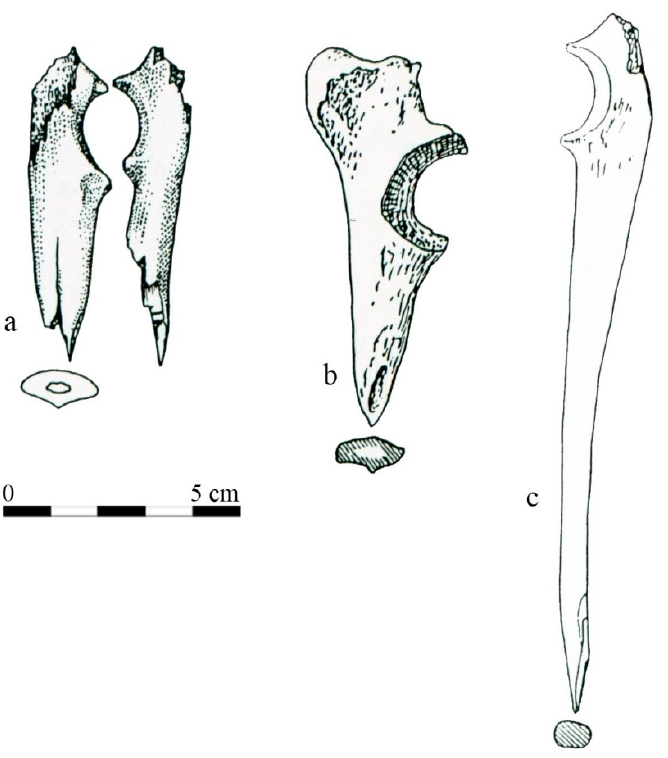
Figure 6. Points made of dog ulna from the Cathedral Island in Wroclaw, ( a – c ) According to [54]. Reproduced with permission from K. Jaworski, Wytwórczo ść i u ż ytkowanie wyrobów z ko ś ci i poro ż a na wroc ł awskim Ostrowie Tumskim w X-XV wieku (Ph.D. thesis); University of Wroclaw, 1993.